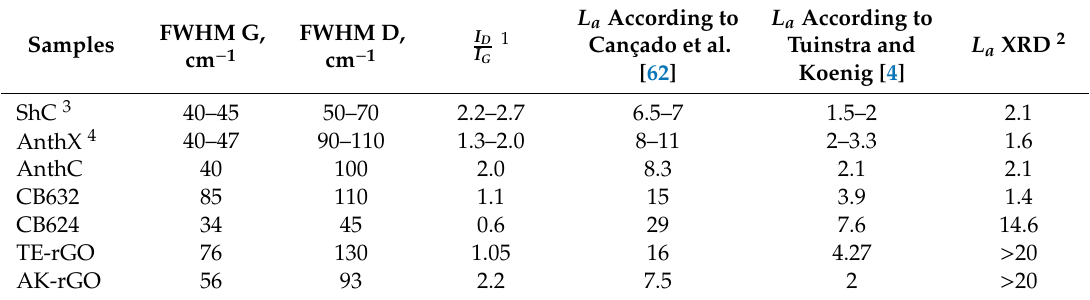
Table 4. Spectral characteristics of one-phonon Raman spectra of sp 2 amorphous carbons and a comparison of the data-treated and independently obtained size of graphene domains L a .